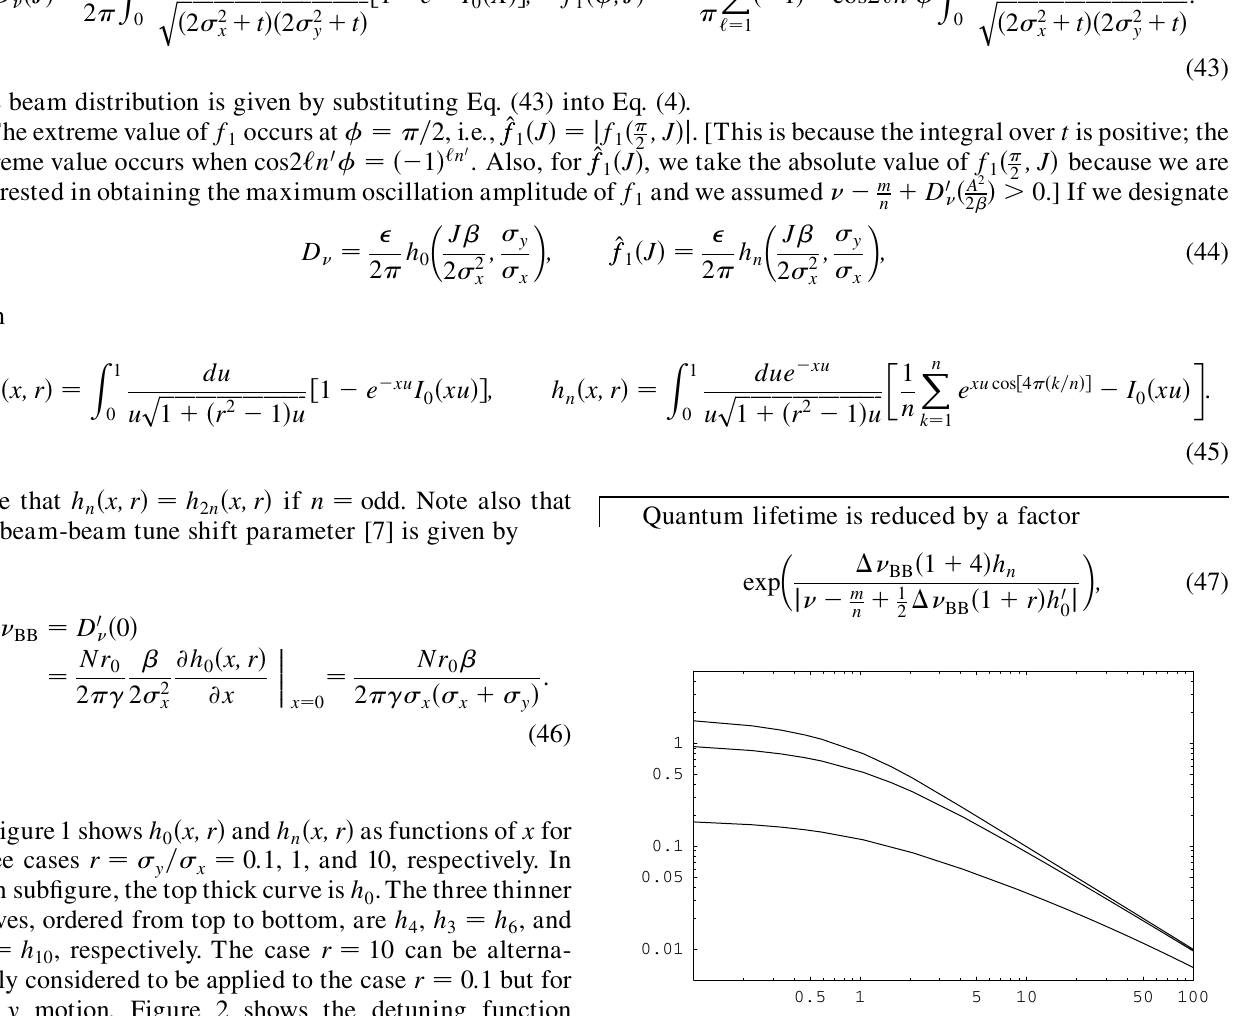
FIG. 1. Functions h